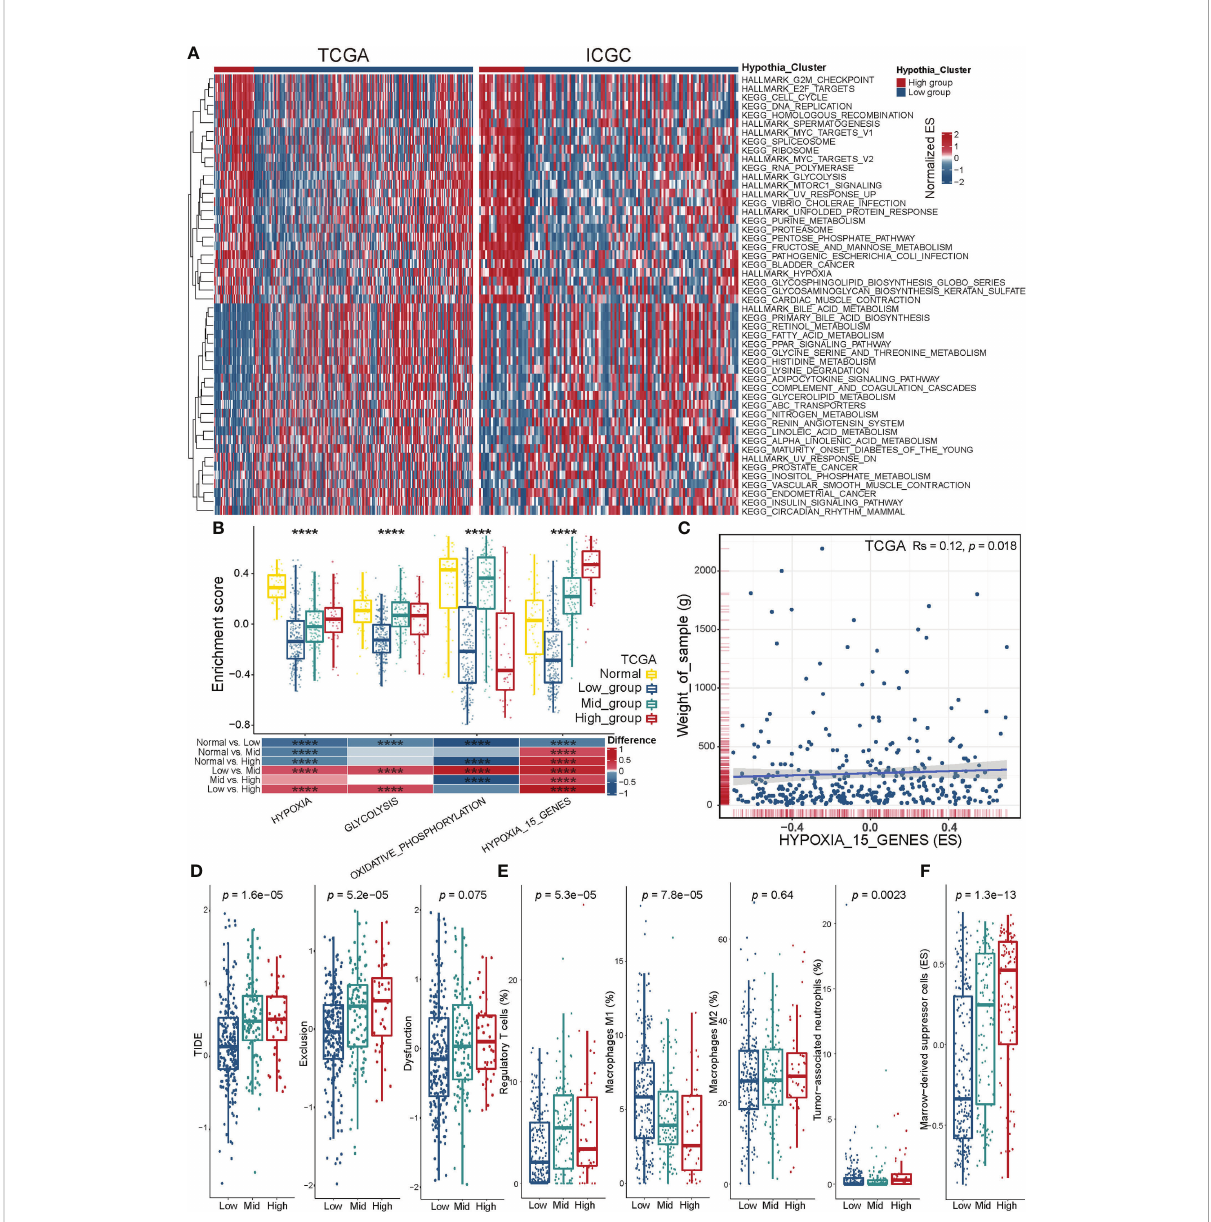
FIGURE 2 Biological characteristics and tumor immune microenvironment of distinct hypoxia groups. (A) Heatmap visualizing the GSVA enrichment analysis based on KEGG and HALLMARK terms showing the activation states of biological pathways in hypoxia high and low groups. Red, activated pathways; blue, inhibited pathways. KEGG, Kyoto Encyclopedia of Genes and Genomes (GO in Figure S4A). (B) Enrichment score of hypoxia-related pathways across distinct hypoxia groups and normal tissue group in the TCGA-LIHC cohort. Upper panel, boxplot showing the ES distribution and overall variance. Bottom panel, heatmap showed between-group differences for pairwise comparisons. P < 0.05 in the Kruskal-Wallis (upper panel) and Wilcoxon tests (bottom panel) was considered statistically signi fi cant. ****P < 0.0001. (C) Scatter plots showing the signi fi cant association between the hypoxia-related 15-gene signature (ES) and tumor weight according to Spearman ’ s rank correlation analysis in the TCGA-LIHC cohort. Rs is the coef fi cient of rank correlation. (D) Box plots showing differences in the TIDE, Exclusion, and Disfunction scores between distinct hypoxia groups in the TCGALIHC cohort. (E, F) Box plots showing differences in the in fi ltration of Tregs, M1 macrophages, M2 macrophages, TANs (E) , and MDSCs (F) between distinct hypoxia groups in the TCGA-LIHC cohort. The in fi ltration of Tregs, M1 macrophages, M2 macrophages, TANs, and MDSCs was estimated using CIBERSORT (E) and ssGSEA (F) , respectively. The Kruskal-Wallis test was used to determine the statistical signi fi cance of the